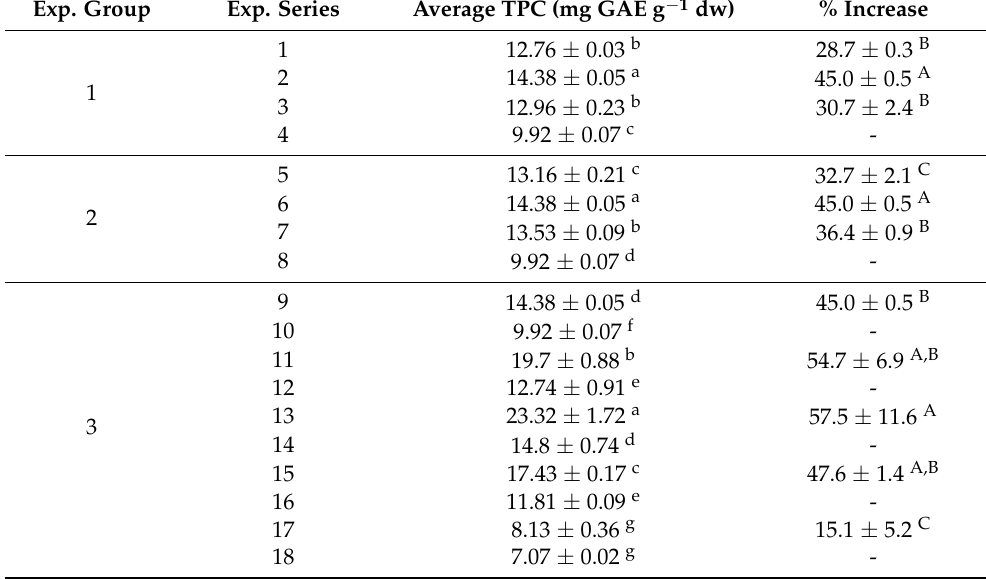
Table 2. Mean values of Elaeagnus leaves extracts’ TPC (mg GAE g − 1 dw); each Exp. section means inside rows with a distinct superscript letter (a–g; A–C) differ significantly ( p < 0.05). “-” denotes no values for control samples (no PEF